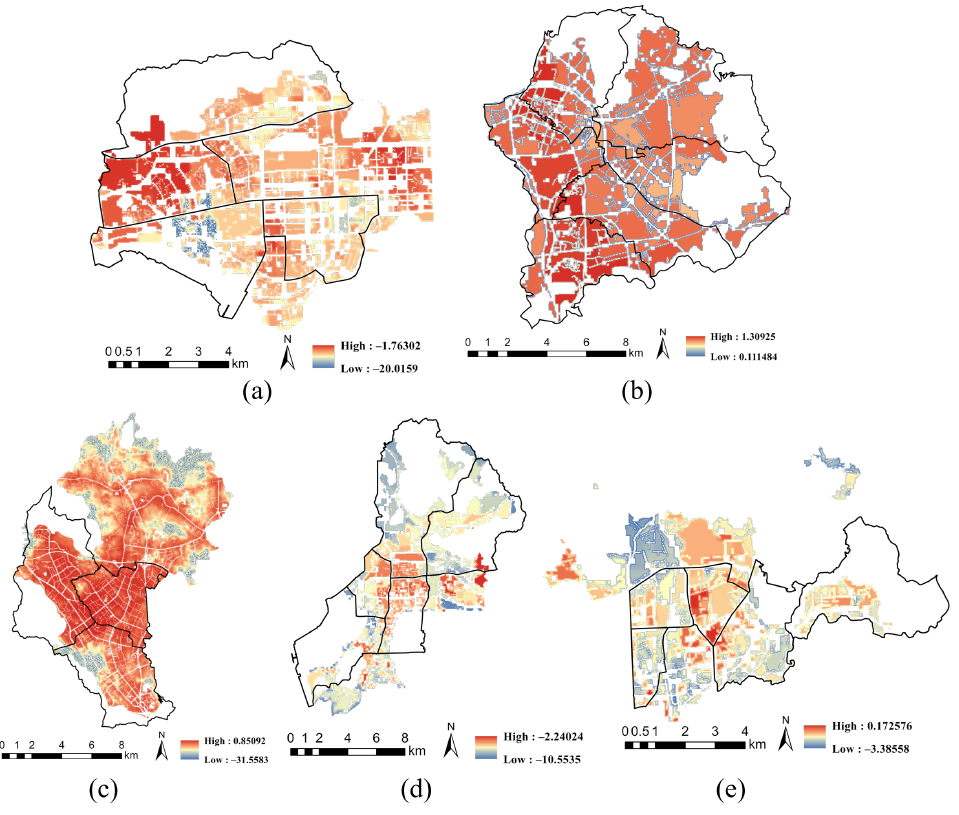
Figure 11. Diffusion coefficients and actual population growth blocks in the five districts of